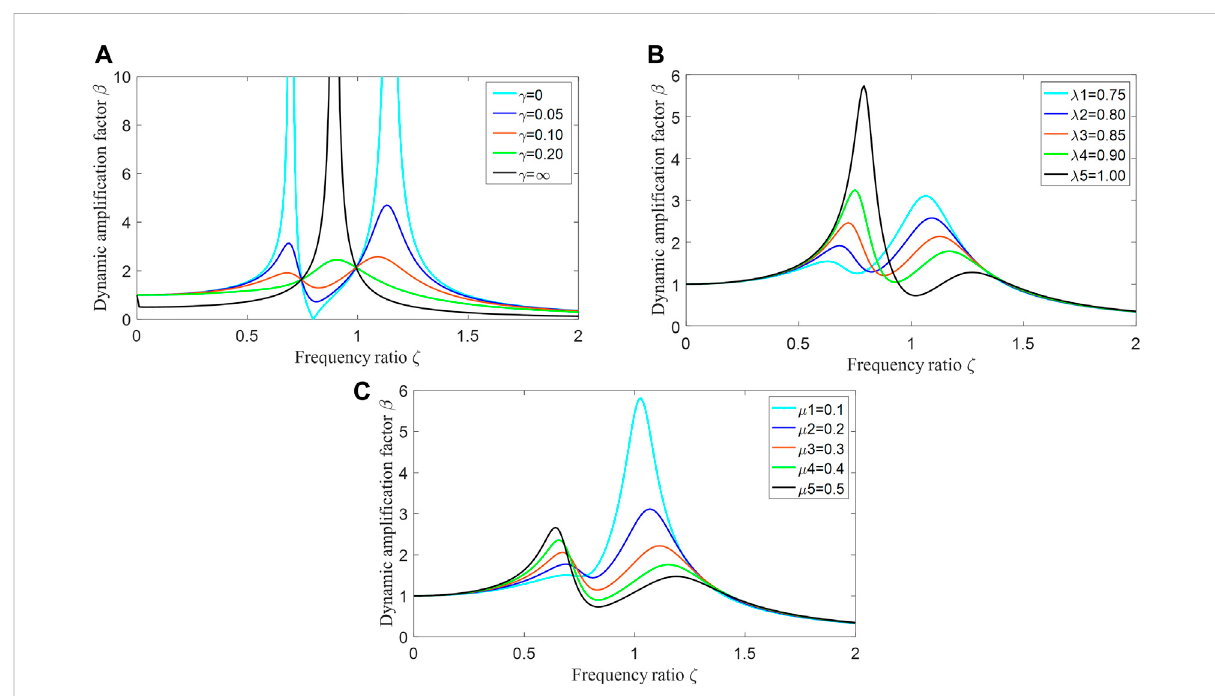
FIGURE 2 Parametric analysis of torsional dampers; (A) Damping ratio; (B) Fixed ratio; (C) Inertia ratio.